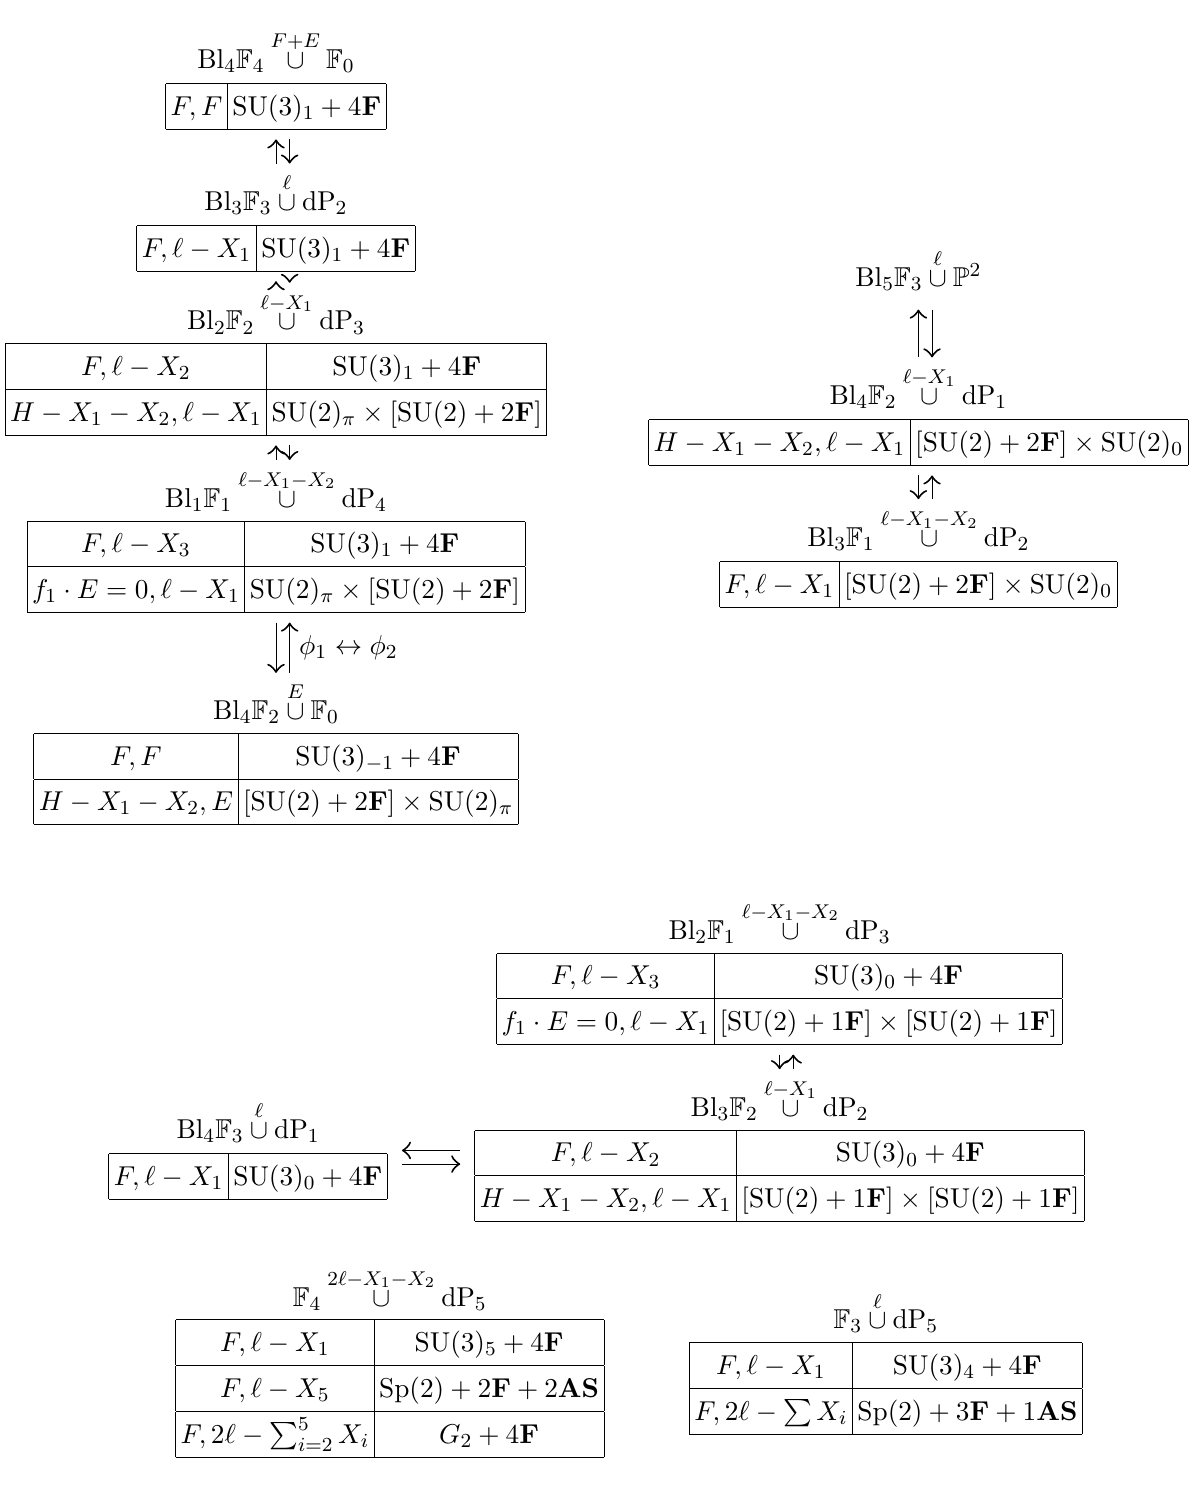
Figure 20. M = 5 geometries,